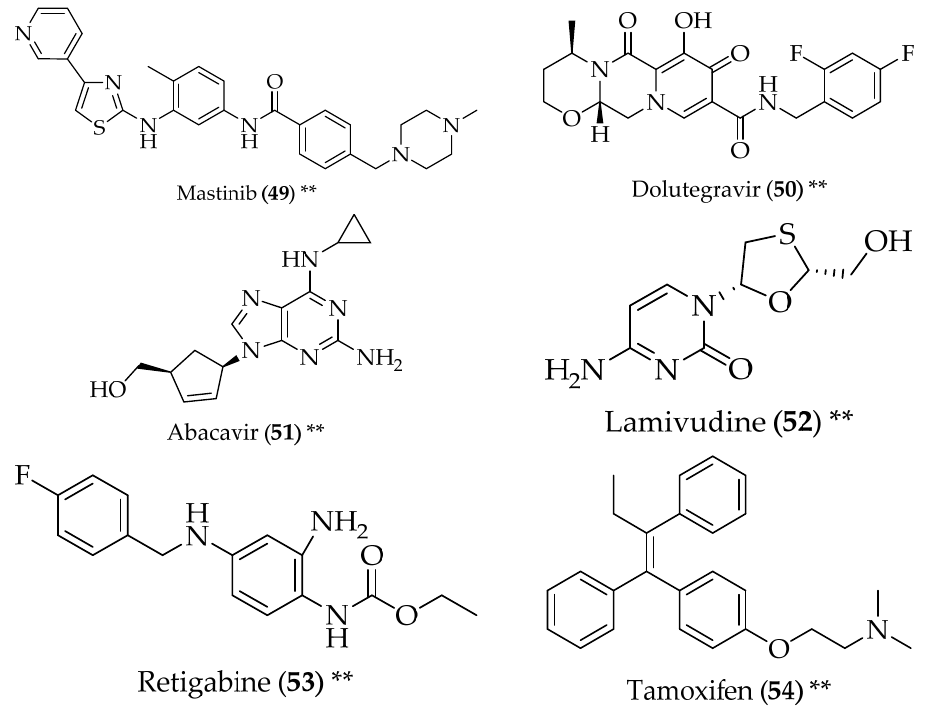
Figure 6. Structure of drugs 49 – 54 (*) Preclinical Studies; (**) Under clinical studies; (***) Clinically approved.